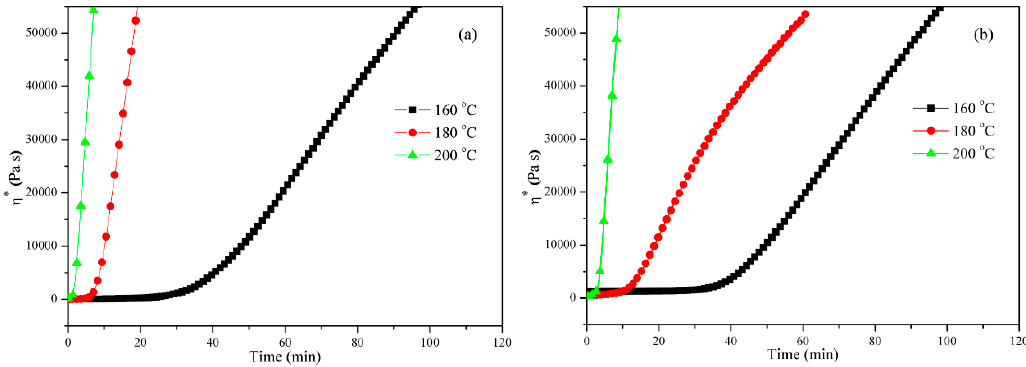
Figure 1. DSC curves of BA ‐ ph/PEN blends, PEN and the cured BA ‐ ph/PEN matrix: ( a ) BA ‐ ph/PEN blends and pure PEN and ( b ) the cured matrix of the BA ‐ ph/PEN blends.